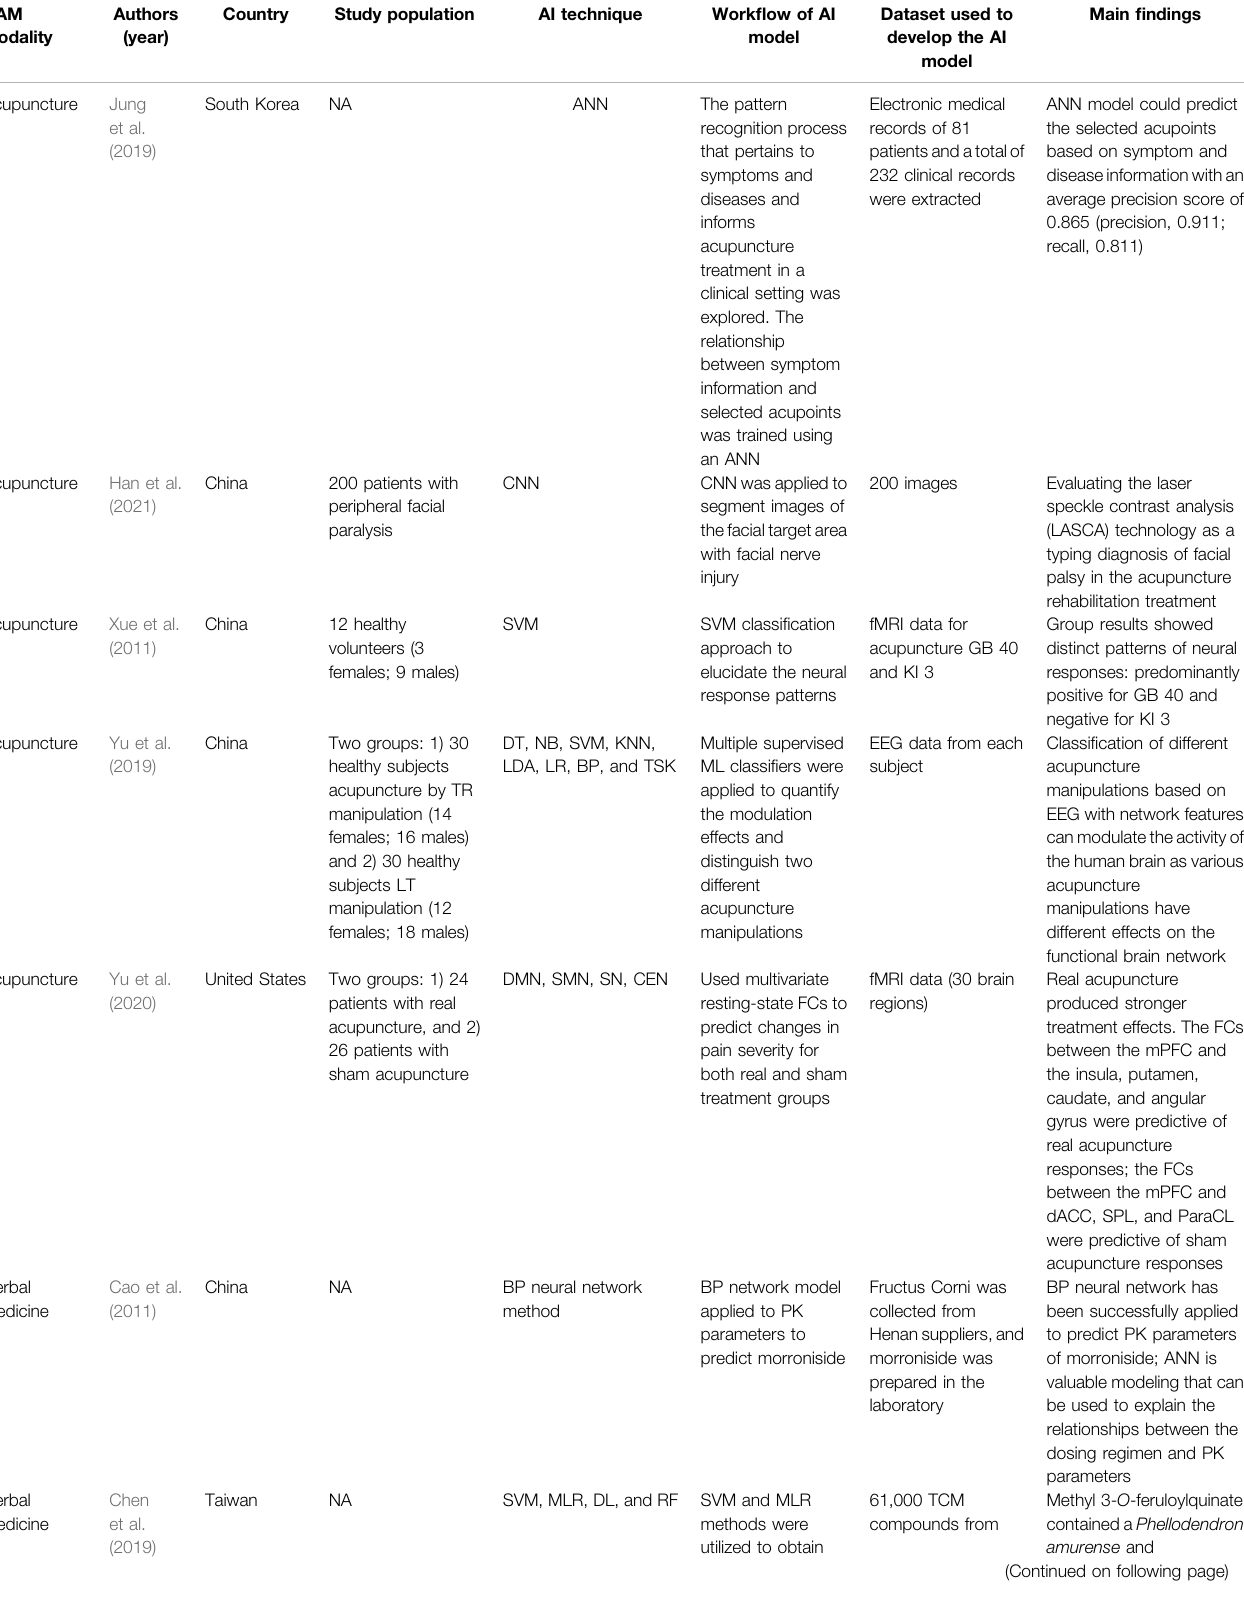
TABLE 2 | Characteristics of included